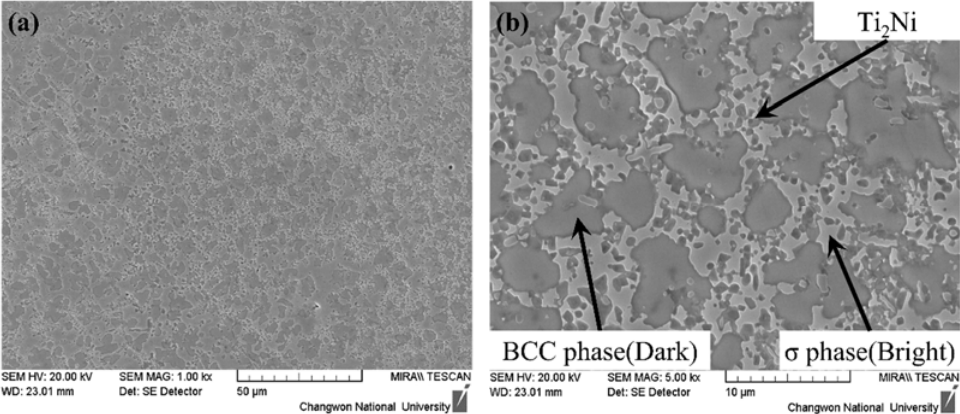
Figure 7. The SEM image of the Ti ‐ Nb ‐ Cr ‐ V ‐ Ni ‐ Al: ( a ) ×1000 magnification and ( b ) ×5000 magnification.